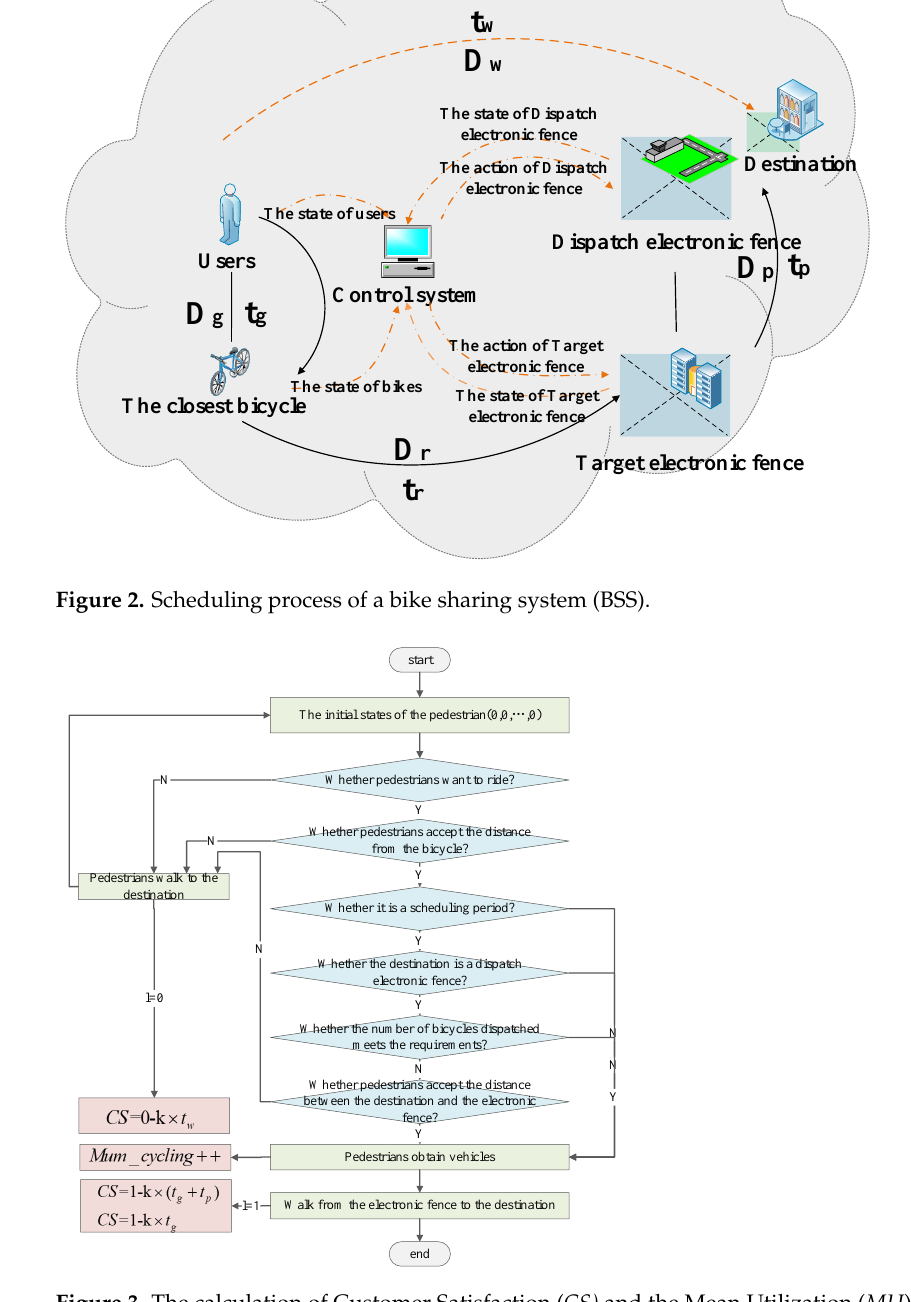
Figure 3. The calculation of Customer Satisfaction ( CS) and the Mean Utilization ( MU) .